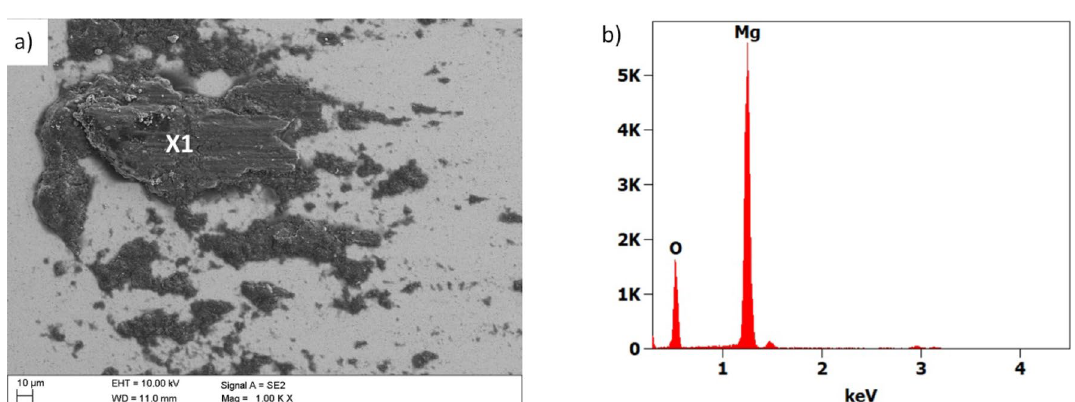
Figure 20. ( a ) Wear place after the "ball-on-plate" wear test for the cemented carbides ball as a counter-sample, ( b ) X-ray energy dispersive plot of the area X1 shown in figure ( a